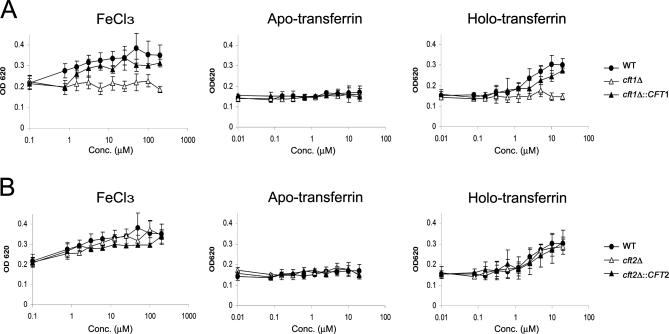

CFT1 Is Required for Reductive Iron Uptake(A) Iron-starved strains (the wild-type, the cft1 mutant and the CFT1 reconstituted strain) were inoculated into media containing FeCl3, apo-transferrin or holo-transferrin, which were added in stepwise 2-fold dilutions. The actual range of concentrations in the cultures was between 200 μM and 0.78 μM of FeCl3, and 20 μM and 0.078 μM of apo- or holo-transferrin. The OD620 reading at 0.1 μM in FeCl3 containing plates and 0.01 μM in Apo- or Holo-transferrin containing plates represent the level of growth in media without an added iron source, starting at the standard inoculum density of 0.08. All cultures were incubated at 30°C and turbidity was measured after 72 h. The averages of three independent experiments are presented with bars representing the standard deviations.(B) The same experiments as shown in (A) were performed for the cft2 mutant and all strains showed similar patterns of growth.